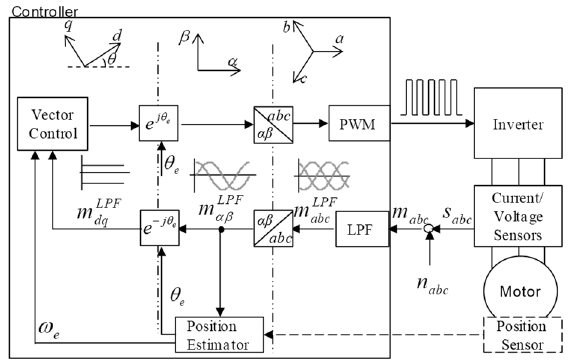
Figure 1. Control signal flow diagram of an AC drive system.